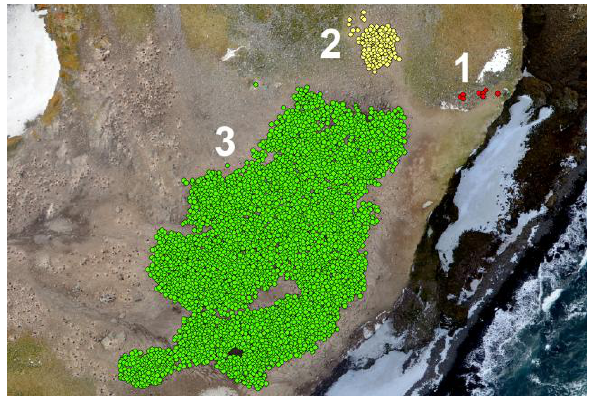
Figure 5. The image of ASPA 151 penguin colony (selected polygon framed in green), an example of results.